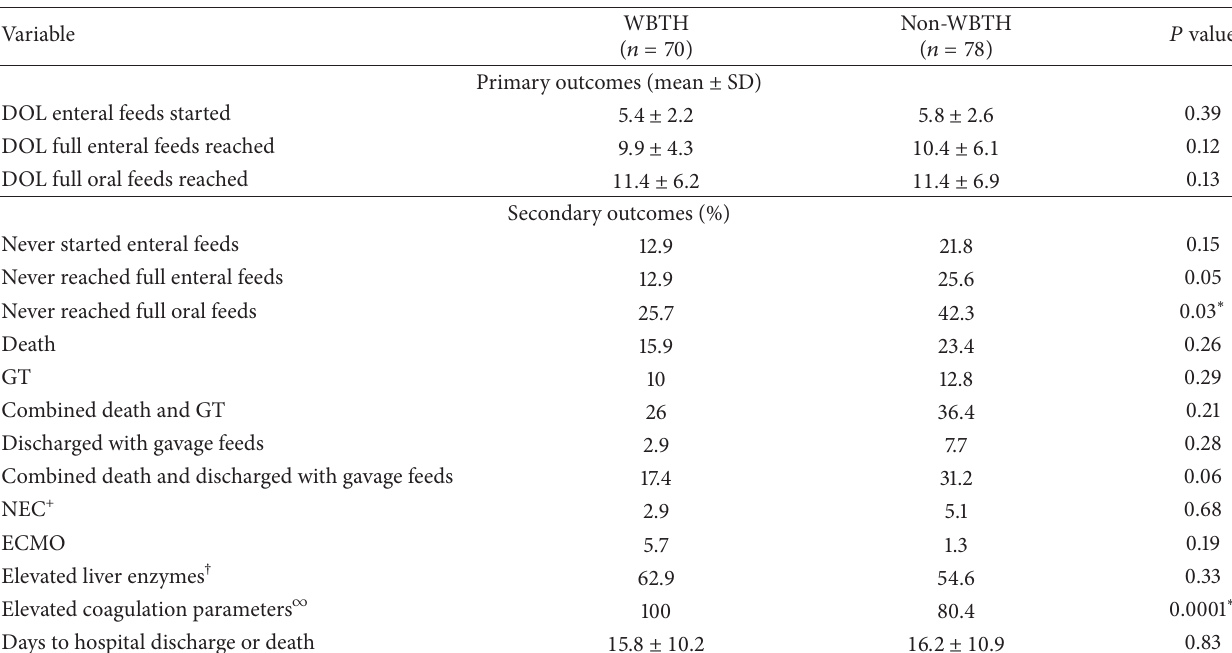
Table 3: Primary and secondary outcome variables for general criteria